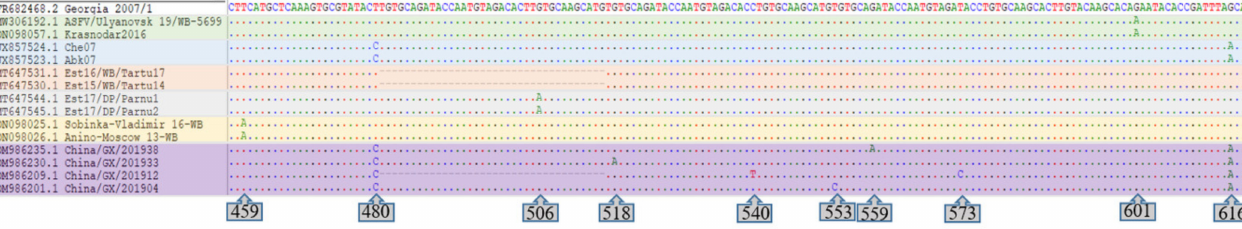
Figure 2. Nucleotide sequence alignment of the partial CVR gene. The six different groups identified in Europe and the RF are expressed in different colors, whilst the four variants unique to China are expressed in violet